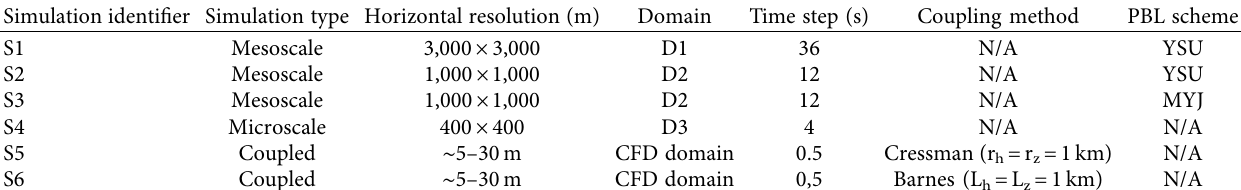
Table 5: Description of S1, S2, S3, S4, S5, and S6 including type, resolution, domain name, time steps, and coupling method. Simulation identifier Simulation type Horizontal resolution (m)